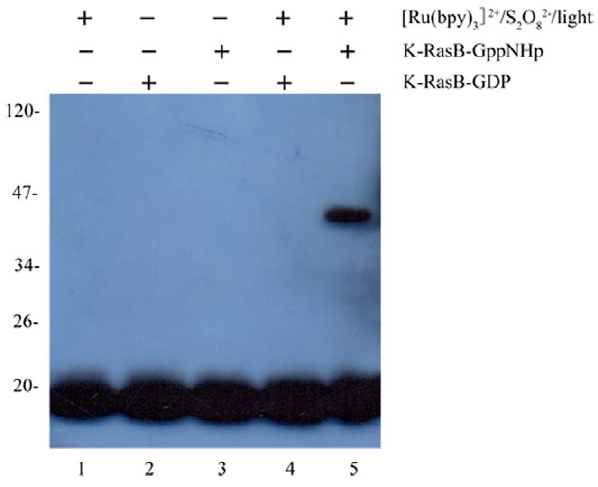
Figure 1. Photo-initiated cross-linking of the Ca 2 + /CaM with K- RasB-GDP and K-RasB-GppNHp. Samples containing Ca 2 + /CaM alone (lane 1), Ca 2 + /CaM and K-RasB-GDP (lane 4), or Ca 2 + /CaM and K- RasB-GppNHp (lane 5), were irradiated for 1 minute with a 150-W common flashlight as described in ‘‘Materials and Methods’’. Samples containing Ca 2 + /CaM and K-RasB-GDP (lane 2), or Ca 2 + /CaM and K-RasB- GppNHp (lane 3) without Ru(bpy) 3 Cl 2 and irradiation were also conducted as controls. Shown is a Western blot using antibody raised against CaM.